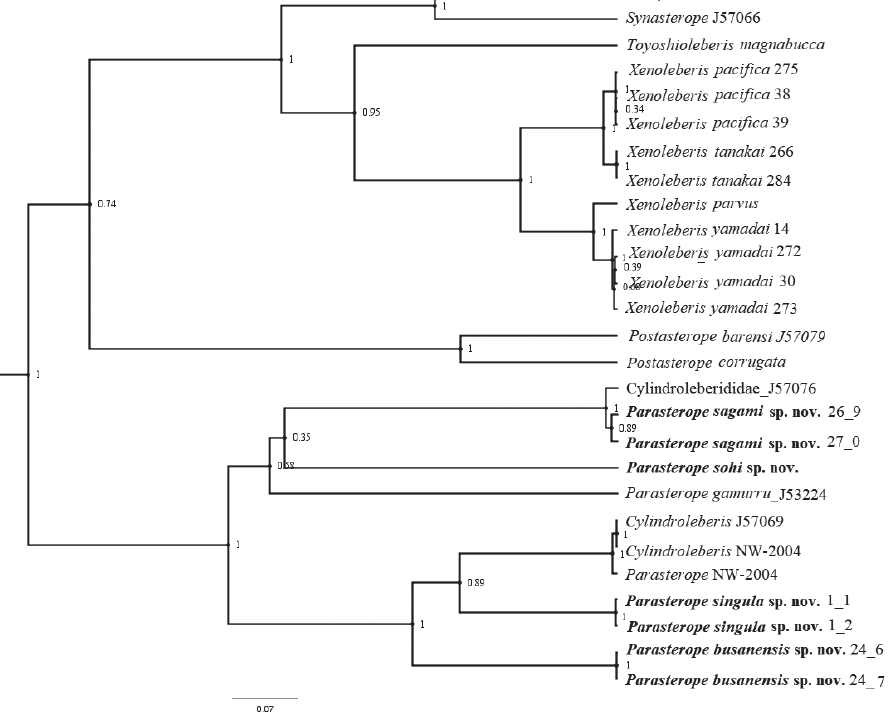
Figure 12. Bayesian inference cladogram of the Cylindroleberidinae subfamily based on 16S rRNA sequences. Numbers at nodes represent posterior